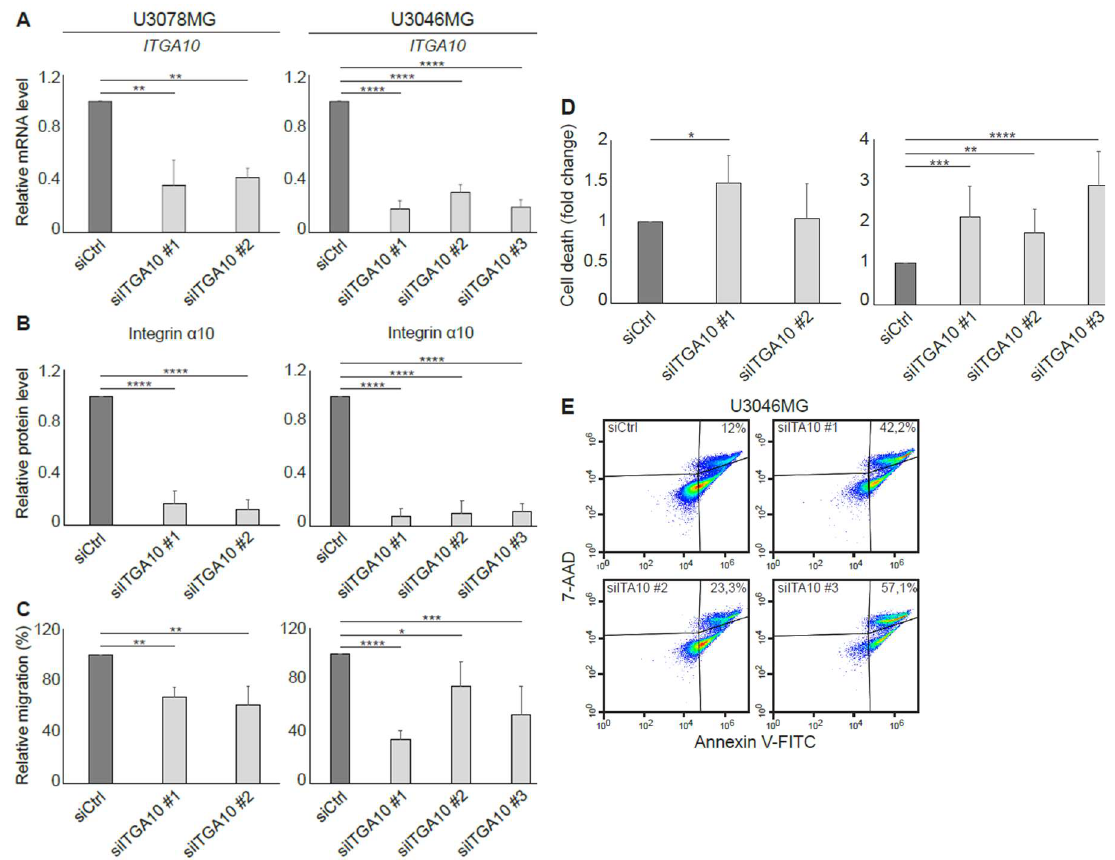
Figure 5. Reduced cell migration capacity and increased cell death of ITGA10 knockdown in GBM cells. The U3078MG and U3046MG cells were transfected for 96 h with siRNA against integrin α 10 (si ITGA10 ) or an unspecific siRNA (siCtrl) as control. ( A ) qRT-PCR analysis of mRNA expression of ITGA10 in the knockdown GBM cells. Expression data were normalized to the reference gene GAPDH. Data are presented as mean ± SD from three independent experiments. ( B ) Flow cytometry analysis of integrin α 10 protein levels in the GBM cells. Data are presented as mean from 8–12 individual experiments. siCtrl is set to 1 for mRNA and protein levels and error bars show the SD. ( C ) Migration capacity of siCtrl and si ITGA10 knockdown cells, evaluated by the transwell migration assay. Data are presented as mean from 3-6 independent experiments. siCtrl is set to 100% and error bars show the SD. ( D ) Number of dead cells evaluated by an Annexin / 7-Aminoactinomycin-D (7-AAD) assay and flow cytometry. The flow cytometry and 7-AAD results are presented as the mean from 8-12 individual experiments and the 7-AAD results demonstrate fold change compared with siCtrl.